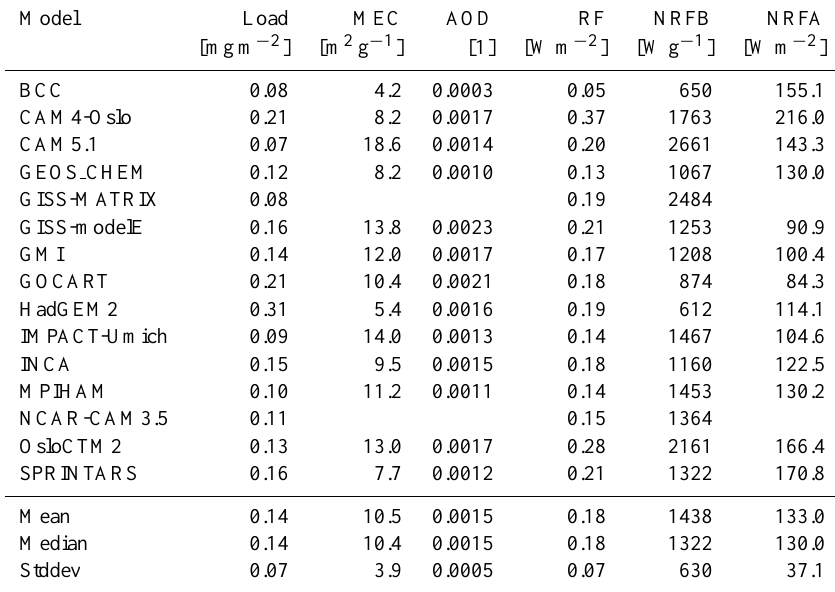
Table 5. Same as Table 4 for BC from FF and BF